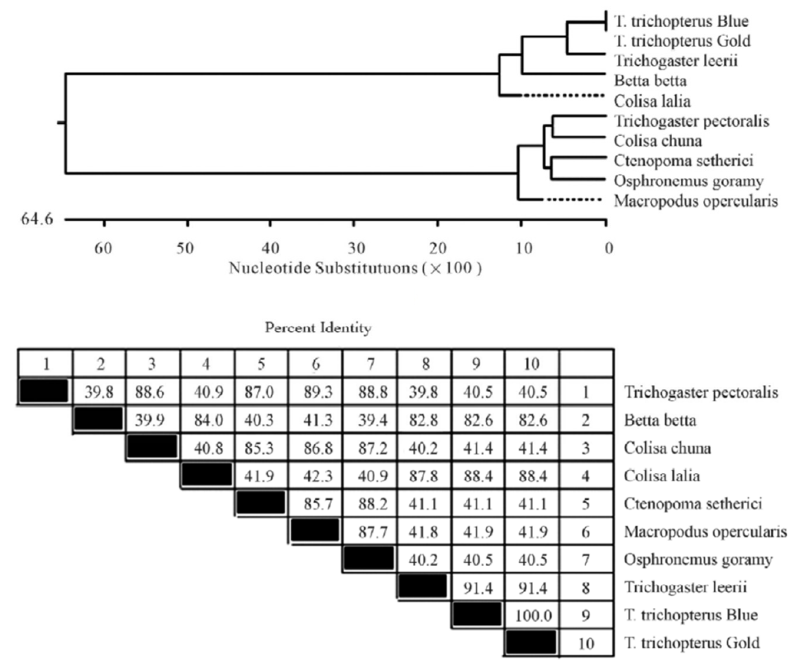
Figure 9. Phylogenetic tree of the 12S rRNA gene fragment based on nucleotide sequences. The length of each pair of branches represents the distance between sequence pairs, while the units at the bottom of the tree indicate the number of substitution events. The phylogenetic tree was constructed by Clustal W and analysis alignment in the MegAlign program (DNASTAR). Percent DNA sequence identities are also shown [2].